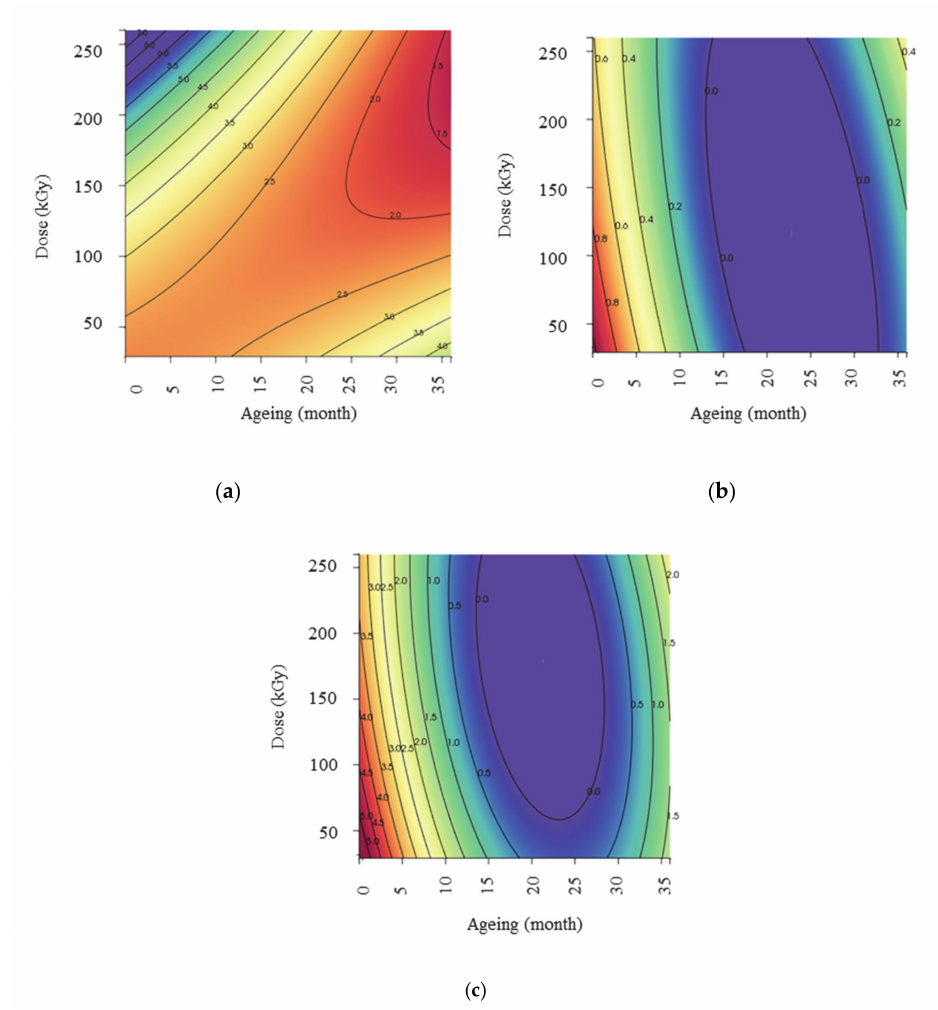
Figure 7. Response surface of the e ff ect of aging (months) vs dose (kGy) ( a ) on the oxidative induction time, Y 1 (day); ( b ) on the methionine sulfoxide formation rate Y 2 ( µ M / day); ( c ) on the maximum methionine sulfoxide concentration detected, Y 3 ( µ